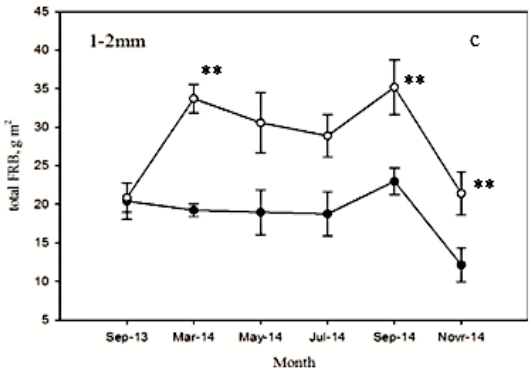
Figure 3. Seasonal variation of P. massoniana fine root ( ≤ 0.5, 0.5–1, and 1–2 mm) biomass (g m − 2 ) in the control and thinned plots (at 0–30 cm soil depth). Closed and open circles represent the fine root biomass in the control and thinned plots, respectively. Error bars denote standard errors. p < 0.01 represents a significant difference. ** p < 0.01.